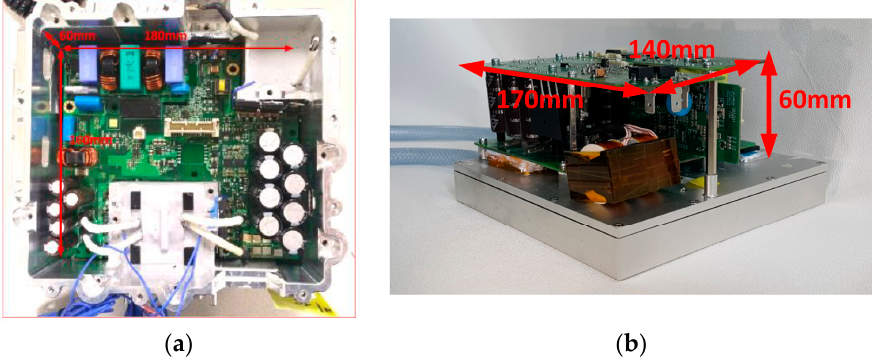
Figure 9. Picture of 3.3 kW OBC. ( a ) Commercial 3.3 kW OBC. ( b ) Proposed 3.3 kW OBC.